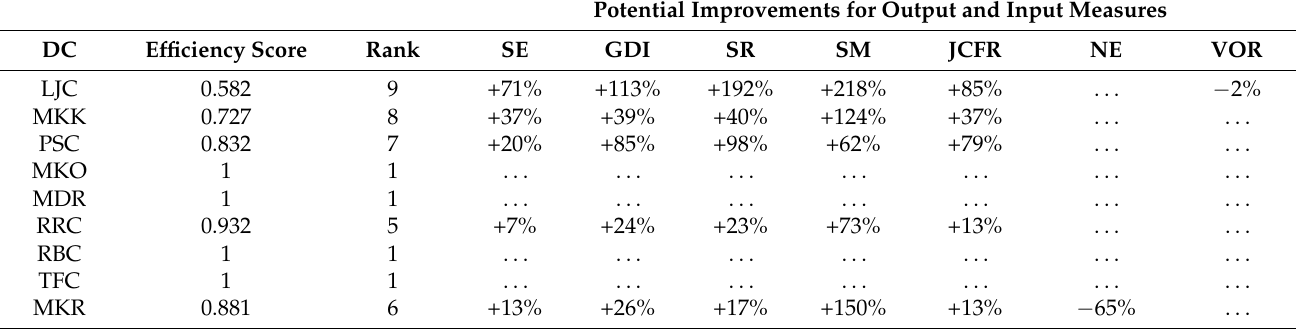
Table 3. Results of the DEA